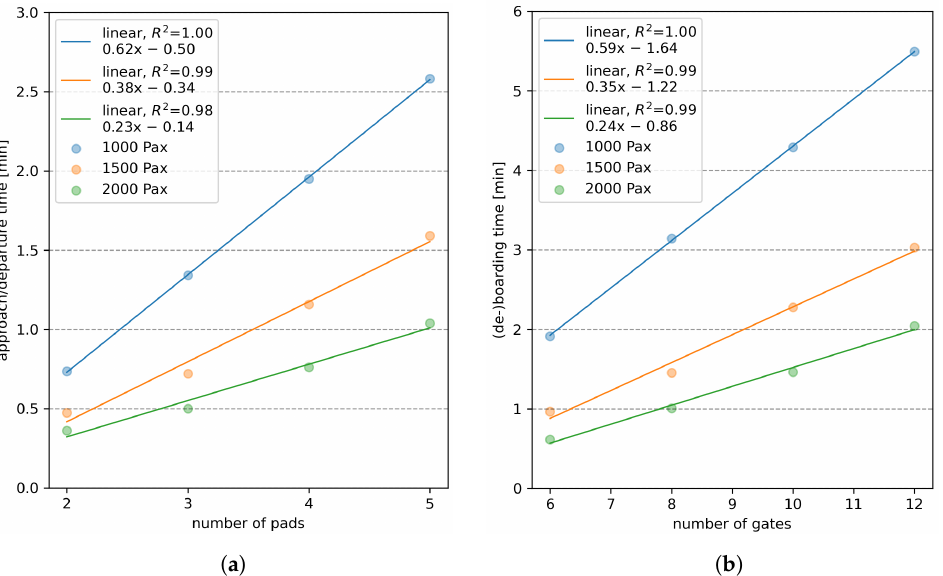
Figure 13. Graphical display of the interchangeability of demand capacity, number of elements and related processes. ( a ) Design heuristic for pad operations. ( b ) Design heuristic for gate